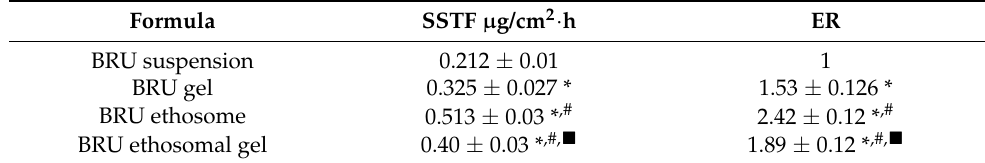
Figure 8. Outline skin permeation study of BRU from developed formulations. Data are expressed as mean ± SD ( n = 3). * p < 0.05 comparable to BRU suspension, ● p < 0.05 comparable to BRU loaded gel and + p < 0.05 comparable to BRU loaded ethosomal gel. Table 5. Special parameters related to ex vivo investigation from BRU formulations.